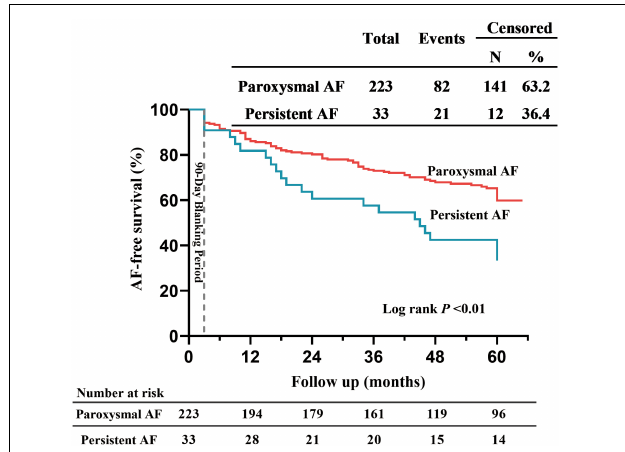
FIGURE 2 | Comparing 5-year outcome in patients with paroxysmal and persistent AF. Kaplan–Meier curves for AF-free survival after single ablation procedure performed using